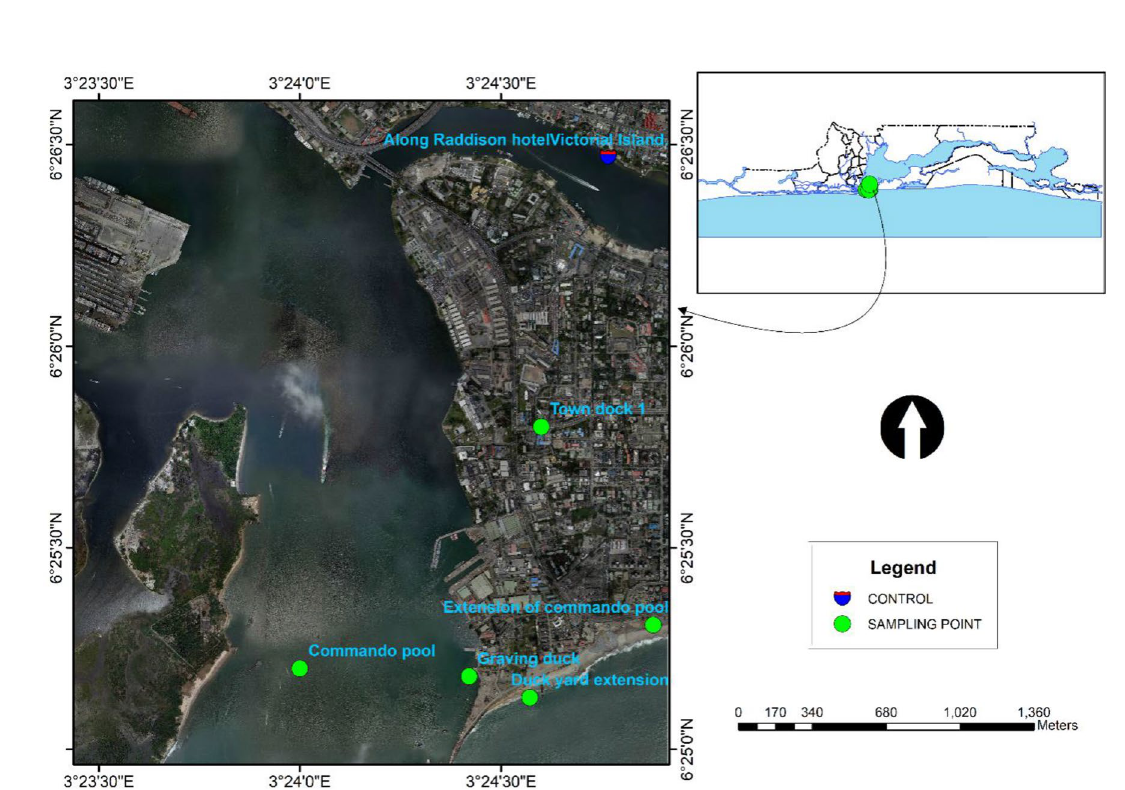
Fig. 1 Map of study